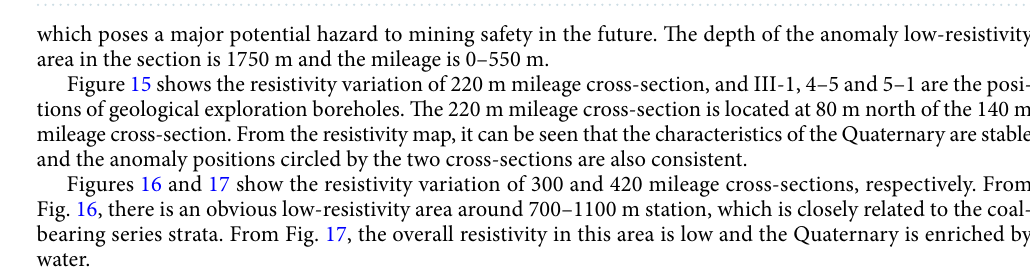
Figure 16. The resistivity profile of the TEM of 300 m mileage